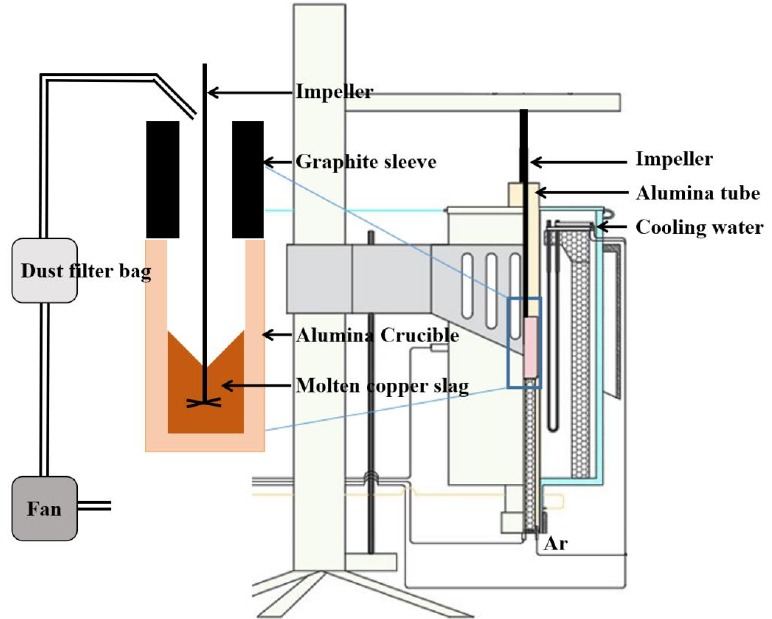
Figure 3. Experimental device.